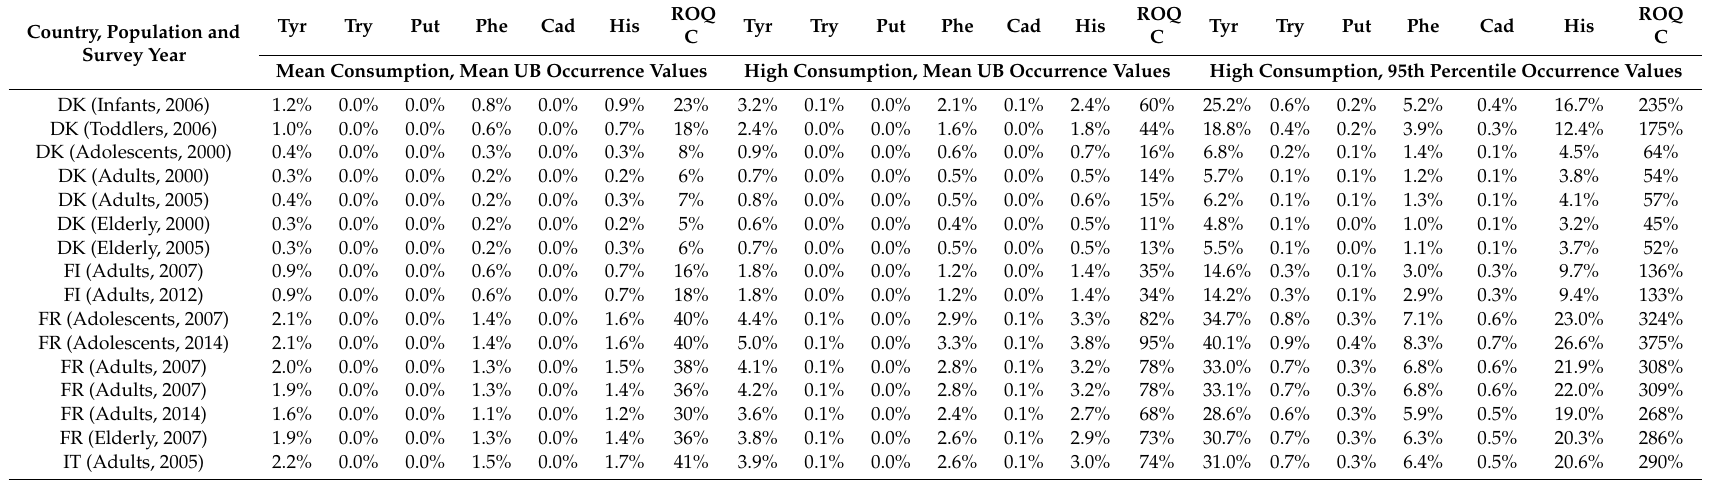
Table 8. Acute dietary exposure to biogenic amines and Roquefortine C (RoQ C) from blue cheese, as percentage of aRfD values. Country, Population and Survey